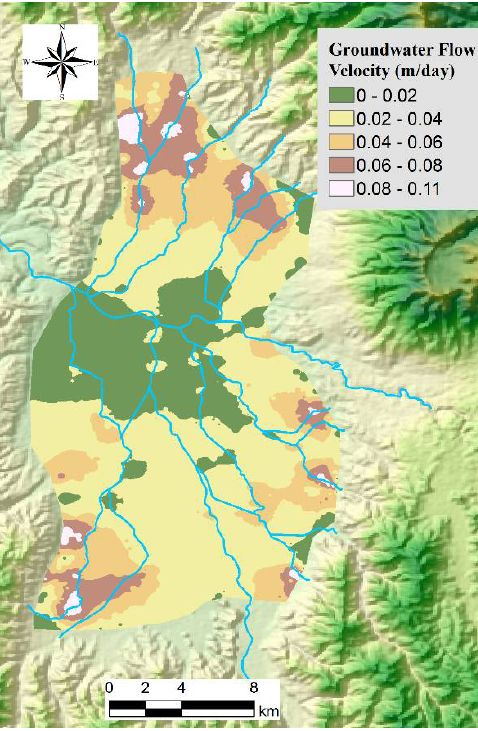
Figure 8. Distribution map of groundwater flow velocity.